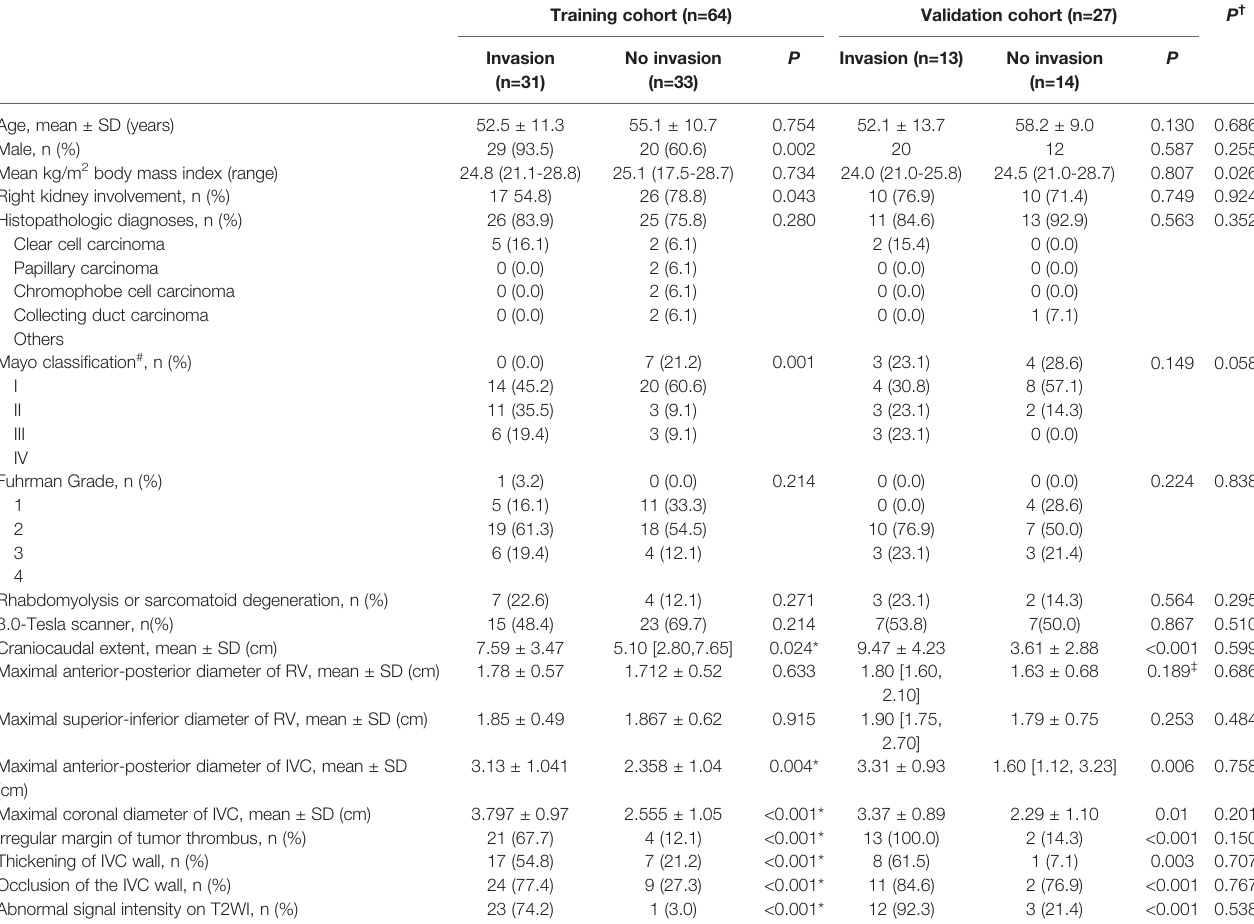
TABLE 1 | Demographic and clinical characteristics in the training cohort and validation